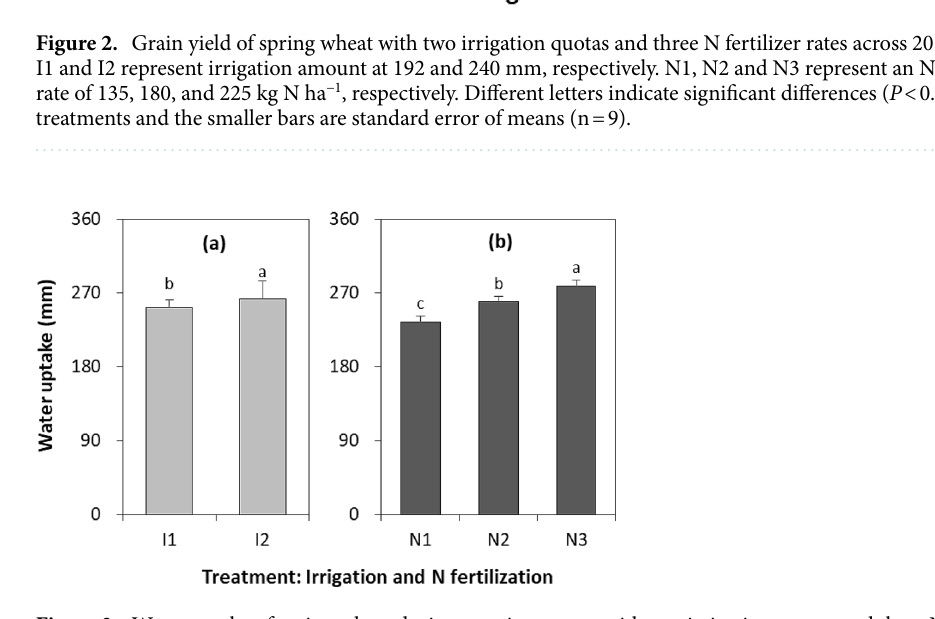
Figure 3. Water uptake of spring wheat during growing season with two irrigation quotas and three N fertilizer rates across 2016–2018. I1 and I2 represent irrigation amount at 192 and 240 mm, respectively. N1, N2 and N3 represent an N fertilizer rate of 135, 180, and 225 kg N ha −1 , respectively. Different letters indicate significant differences ( P < 0.05) among treatments and the smaller bars are standard error of means (n =